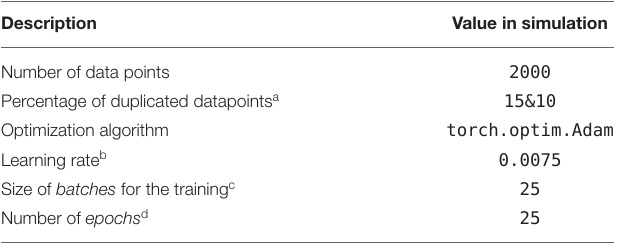
TABLE 2 | Table of parameters for the CAE-model